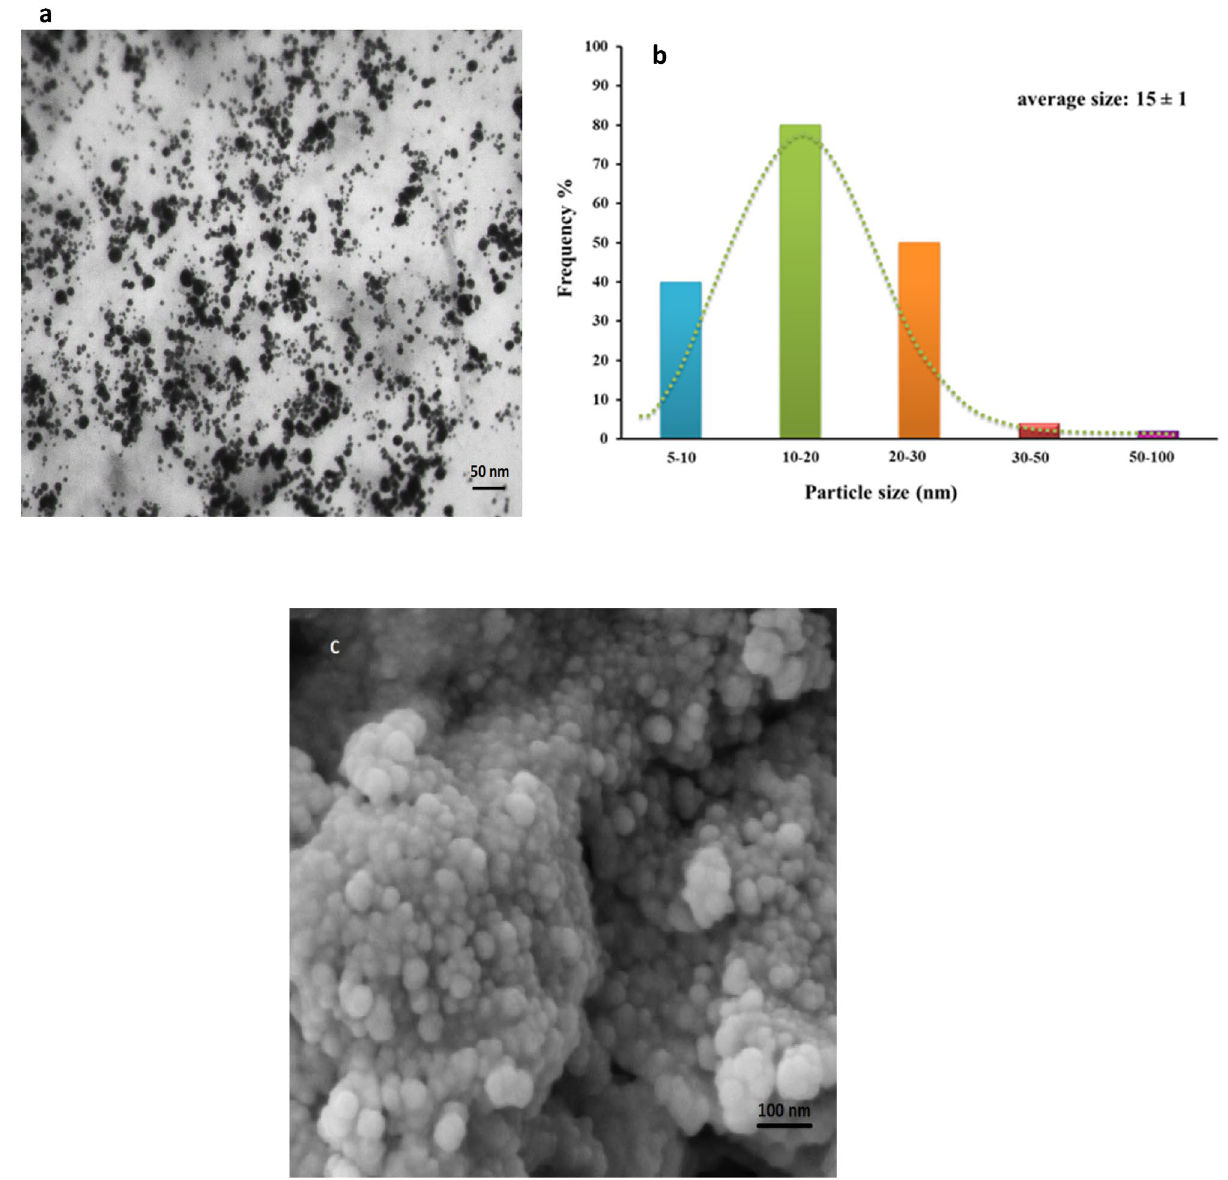
Figure 8. ( a ) TEM image, ( b ) particle size distribution histogram plot, and ( c ) SEM image of the marine oyster assisted biosynthesized CeO 2